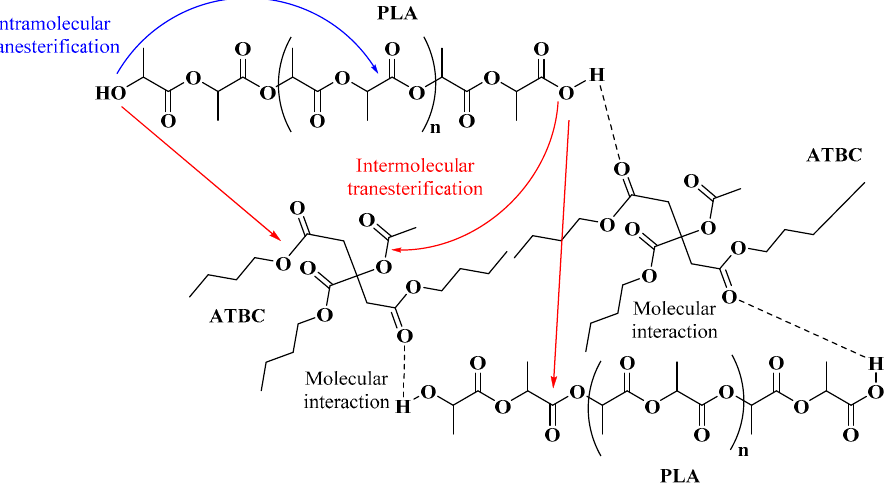
Figure 6. Proposed transesterification reactions and molecular interactions.